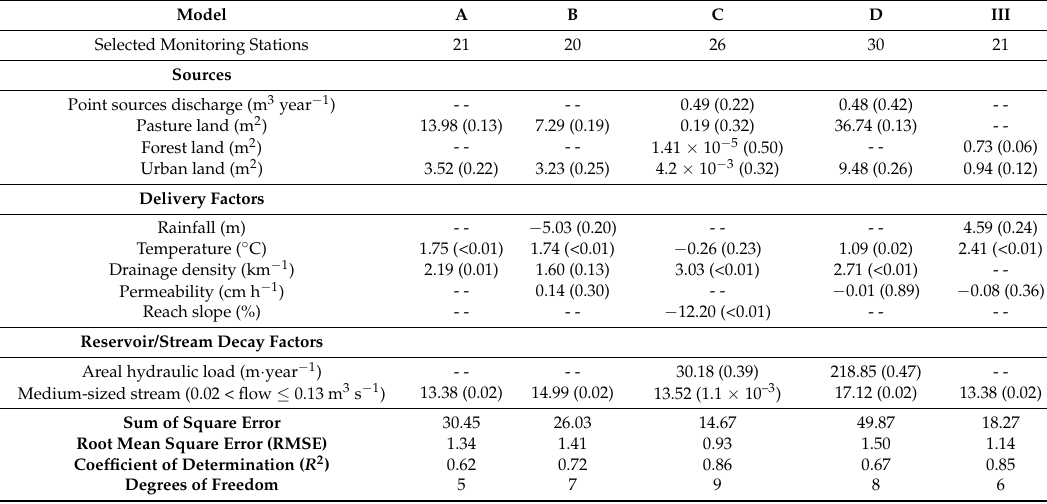
Table 2. Model coefficients and p -values (in) for the source, land–water delivery, and stream/reservoir attenuation